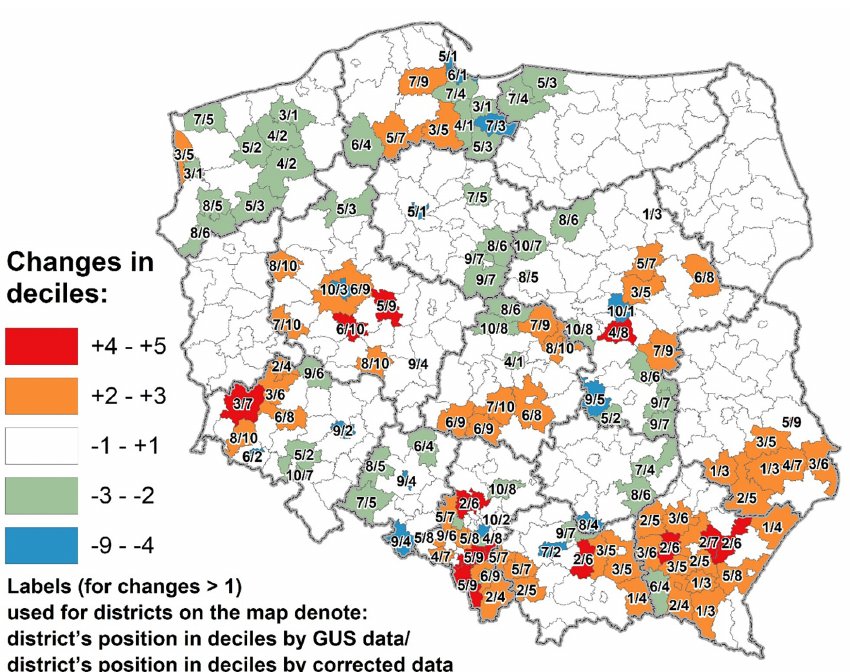
Fig. 6. Collation of the spatial distribution of car ownership rate values in Poland, in line with GUS and CEP data, following the authors’ correction (31 December 2018). GUS – Statistics Poland; CEP – Central Vehicle Register. Source: authors’ own elaboration based on GUS and CEP